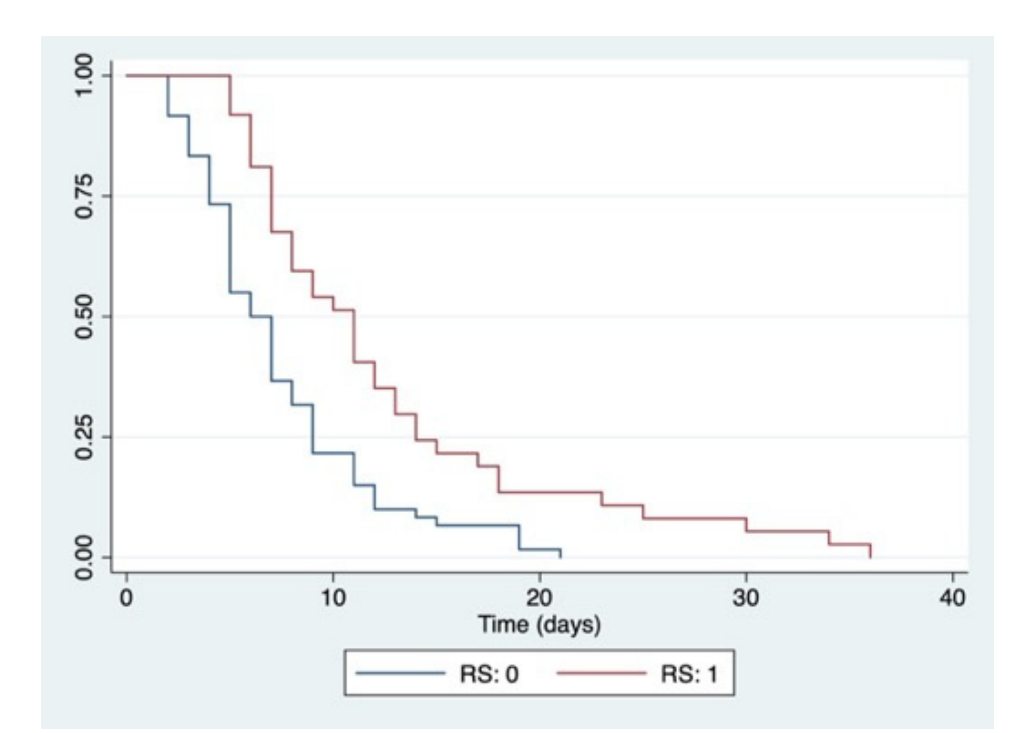
Table 4. Univariate analyses of risk factors associated with in-hospital mortality ( n = 9) .